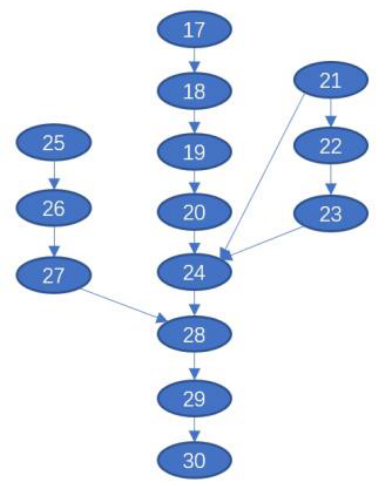
Figure 9. The correlate graph based on the three patterns (17~29, 21~30, 25~24).